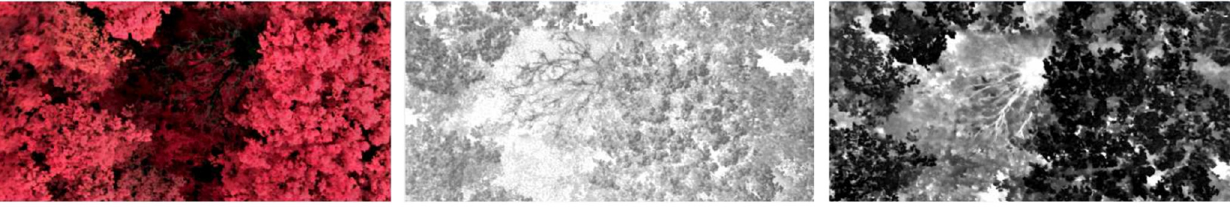
Figure 4. Subsets of the UAS derived CIR mosaics from the oak forest stands site (left) and the corresponding NDVI mod (center) and 2nd PC (right). Infested oaks are indicated by low or high grey values due to low biomass (NDVI mod ) and strong uncorrelated NIR/visible variations (2nd